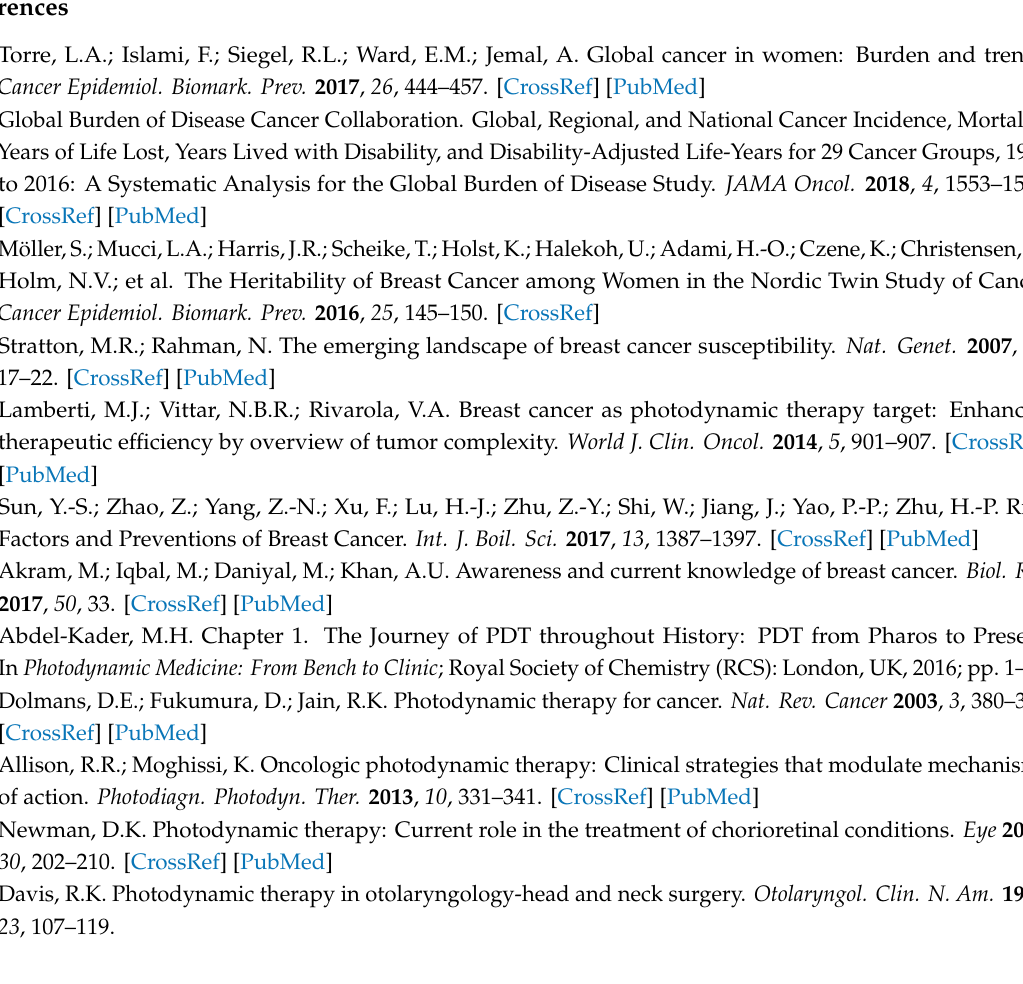
Figure S1: 1 H NMR spectrum of compound 5 (600 MHz, CDCl 3 , ppm). Residual solvent peaks: *Et 2 O, **CH 3 OH.; Figure S2: 13 C NMR spectrum of compound 5 (150.90 MHz, CDCl 3 , ppm). Residual solvent peak: *Et 2 O.; Figure S3: HRESI-TOFMS spectrum of compound 5 .; Figure S4: 1 H NMR spectrum of dye 9 (600 MHz, CDCl 3 , ppm). Residual solvent peak: *CH 3 OH.; Figure S5: 13 C NMR spectrum of dye 9 (150.9 MHz, CDCl 3 , ppm); Figure S6: HRESI-TOFMS spectrum of dye 9 .; Figure S7: 1 H NMR spectrum of dye 10 (400 MHz, CDCl 3 , ppm). Residual solvent peaks: *CH 2 Cl 2 , **CH 3 OH.; Figure S8: 13 C NMR spectrum of dye 10 (150.9 MHz, CDCl 3 , ppm). Residual solvent peaks: *Et 2 O, **CH 2 Cl 2 .; Figure S9: LRESI-TOFMS spectrum of dye 10 .; Figure S10: 1 H NMR spectrum of dye 11 (600 MHz, DMSO- d 6 , ppm); Figure S11: 13 C NMR spectrum of dye 11 (150.9 MHz, DMSO- d 6 , ppm); Figure S12: LRESI-TOFMS spectrum of dye 11 .; Figure S13: 1 H NMR spectrum of dye 12 (600 MHz, DMSO- d 6 , ppm). Residual solvent peak: *CH 2 Cl 2 .; Figure S14: 13 C NMR spectrum of dye 12 (150.9 MHz, DMSO- d 6 , ppm). Residual solvent peak: *CH 2 Cl 2 .; Figure S15: LRESI-TOFMS spectrum of dye 12